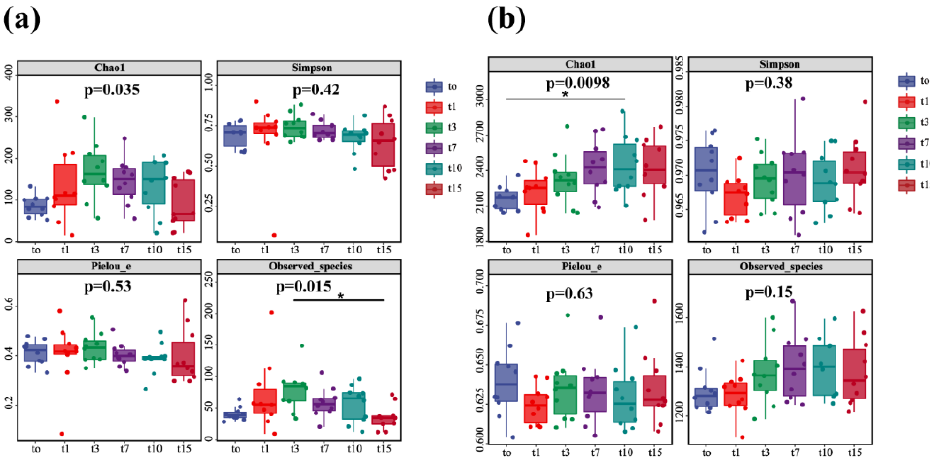
Figure 8. Diversity analysis of nitrifying bacteria ( a ) and denitrifying bacteria ( b ) ( the “ * ” expres- sion p < 0.05 ) .